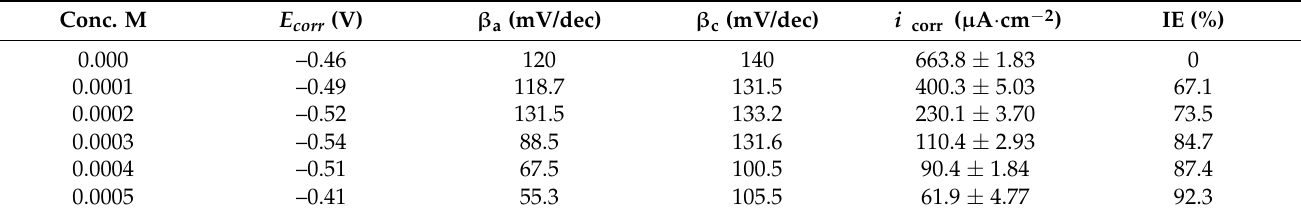
Figure 7. Polarization curves of tested coupons in 1 M HCl solution with different concentrations of PMBMH. Table 3. Tafel parameters for tested coupon without and with the addition of various concentrations of PMBMH in 1 M HCl solution. Conc. M